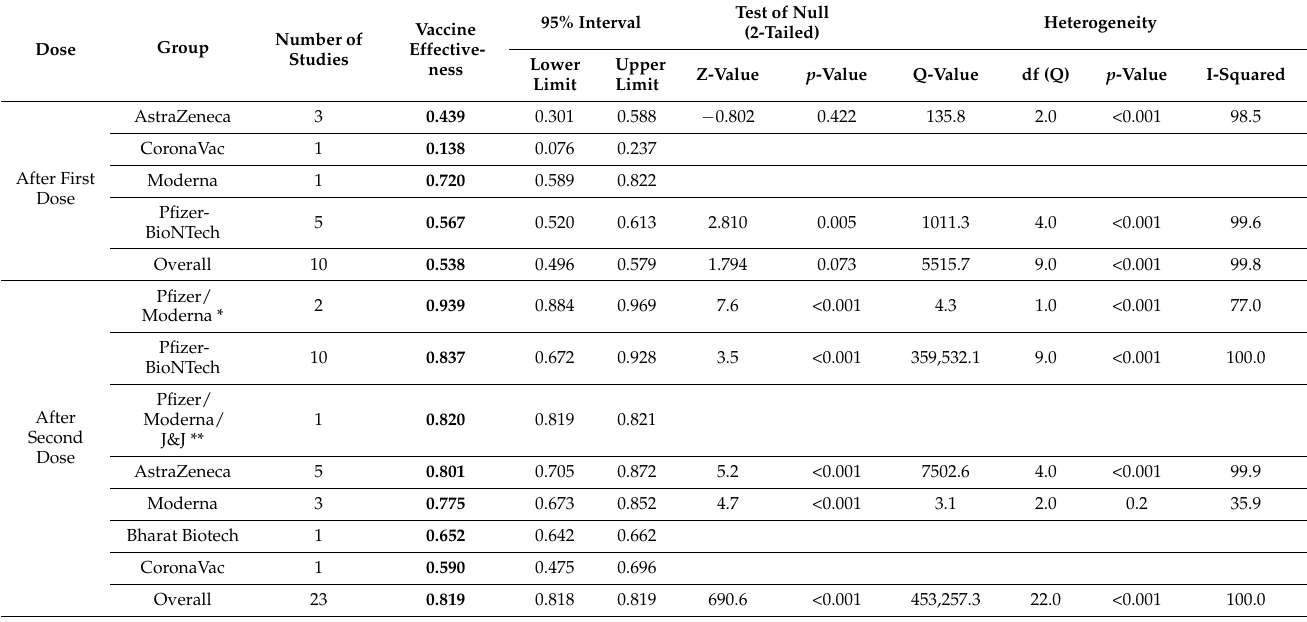
Table 2. Effectiveness of COVID-19 vaccines against Delta